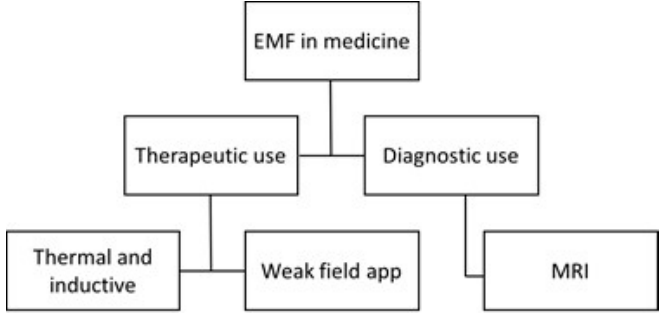
Figure 1. Division of electromagnetic field within the healthcare system.